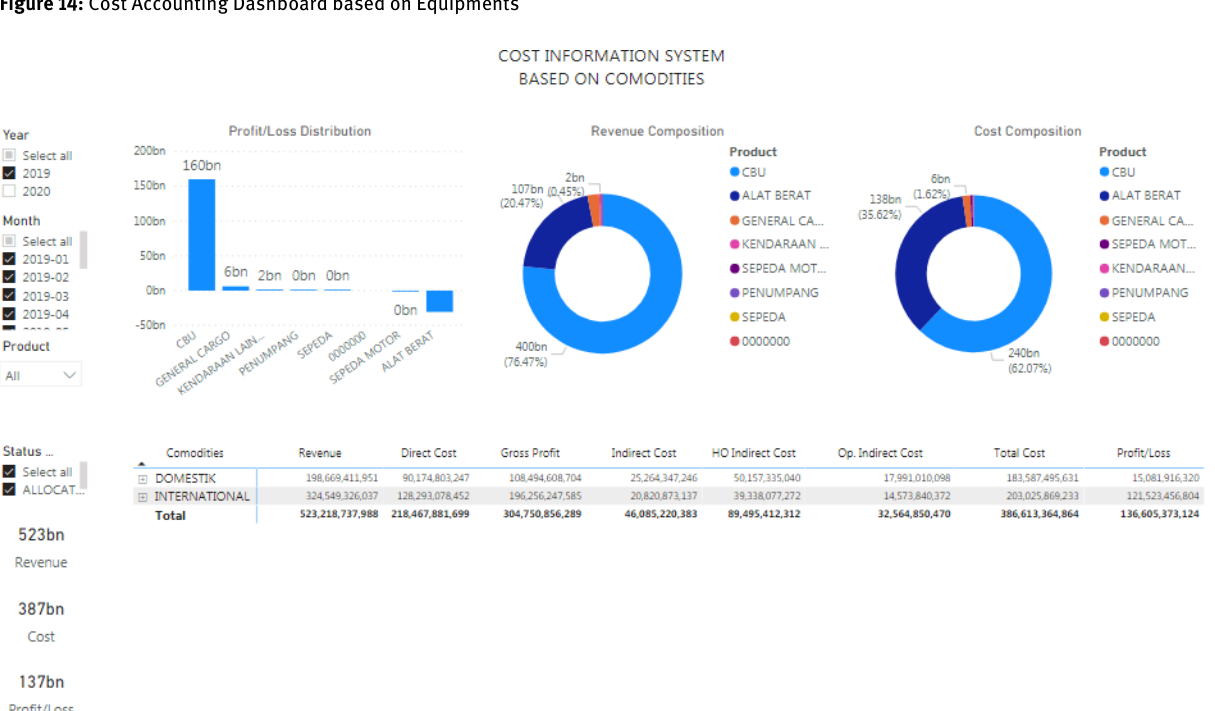
Figure 13 contains information on the composition of the company’s revenue, costs, and profit and loss seen from the perspective of the company’s customers. In the cost of customer accounting report, the income statement